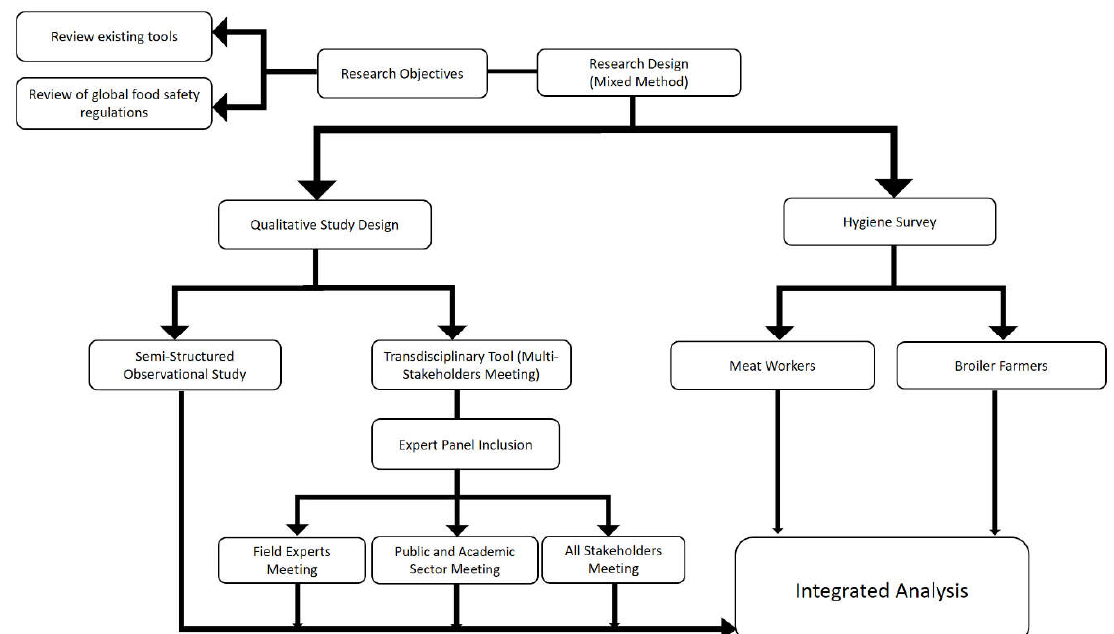
Figure 3. Methodology framework to assess the hygiene practices from farm to fork.